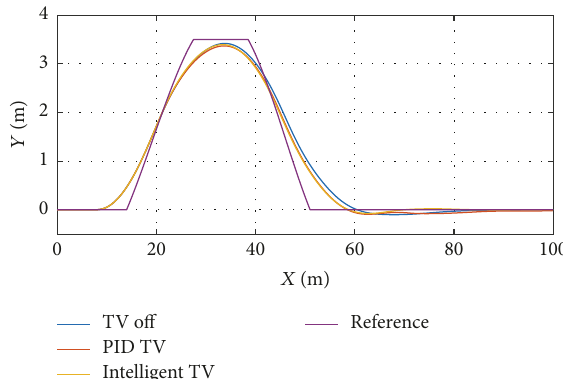
Figure 14: Vehicle speed.